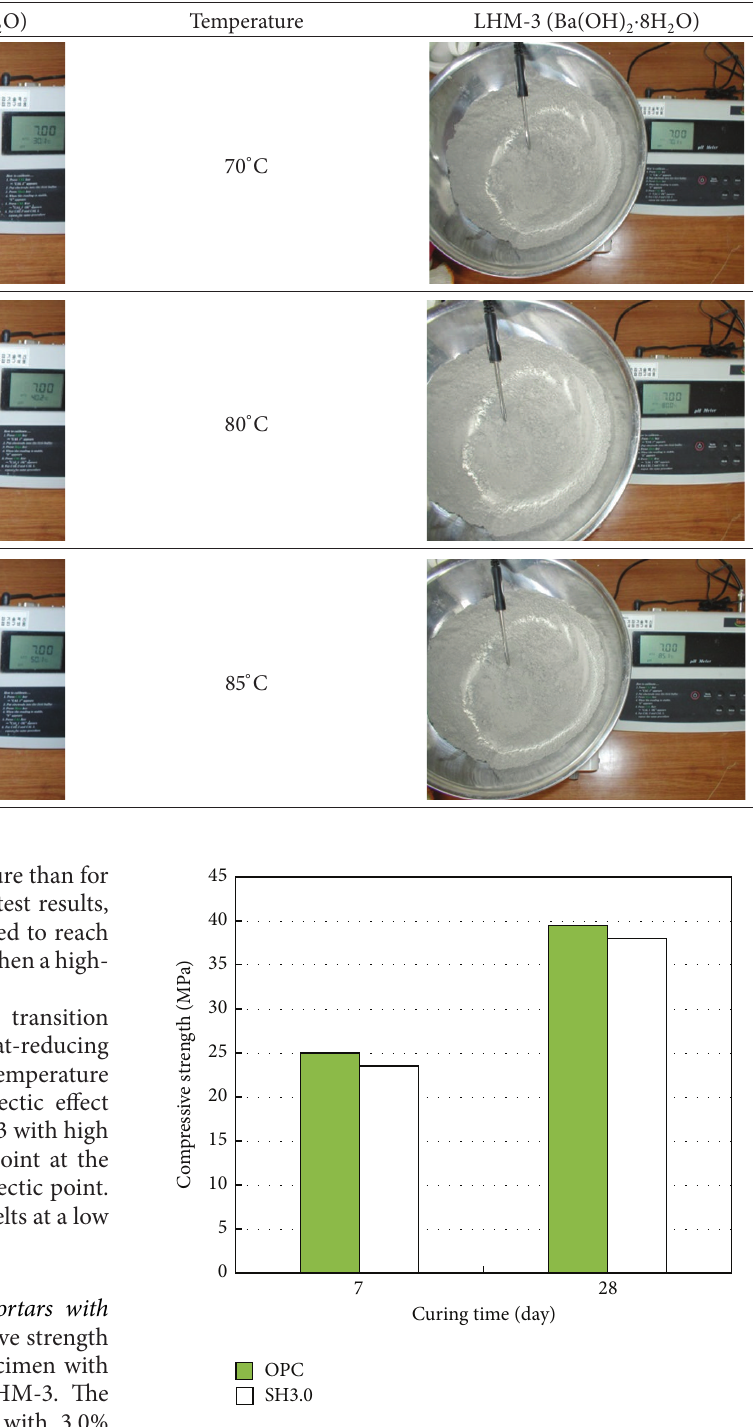
Figure 5: Compressive strength according to 3.0% LHM-3